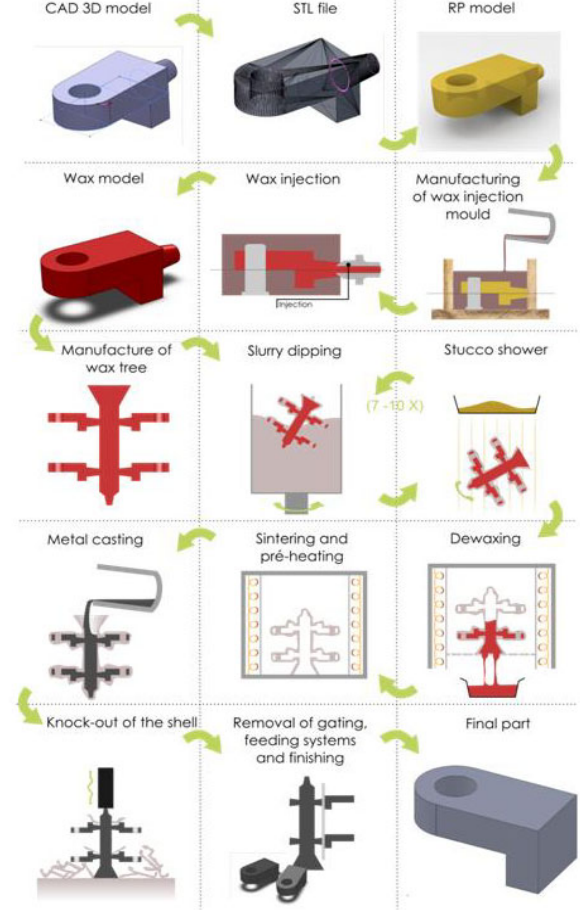
Figure 10. Casting the ceramic slurry and final ceramic mould.